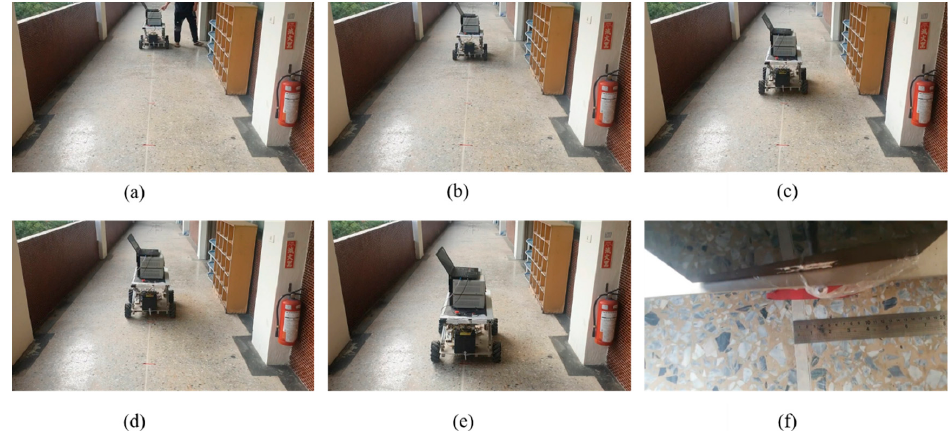
Figure 26. The OMWAGV with a load of 46 kg walking a distance of 400 cm with RLS estimation and compensation. ( a ) Starting position, ( b – e ) at middle way, and ( f ) deviation at stop position.